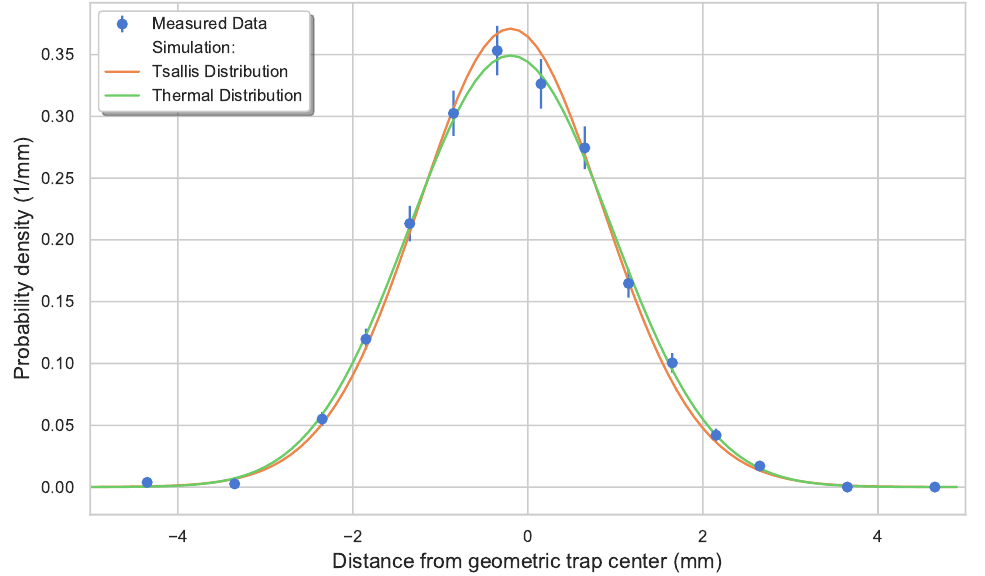
Figure 6. Column density profile as a function of the axial laser position along the cylindrical axis of the trap. Each point was derived by fitting a first-order exponential decay to the ion signal for multiple interaction times with a far-threshold laser beam. The standard deviation of the fits are presented by the error bars. The measured density distribution is compared with the simulated potential which accounts for surface charges. Equations (5) and (6) are used to derive a density distribution from this potential using the simulated energy distribution from Figure 5. The probability density curves shown here are normalized to